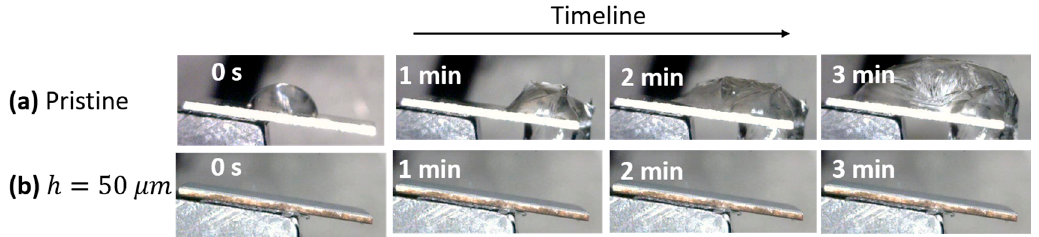
Figure 7. Time evolution of water accumulation ( a ) on the pristine surface compared with ( b ) the laser-treated Al2024 one (at − 20 °C).